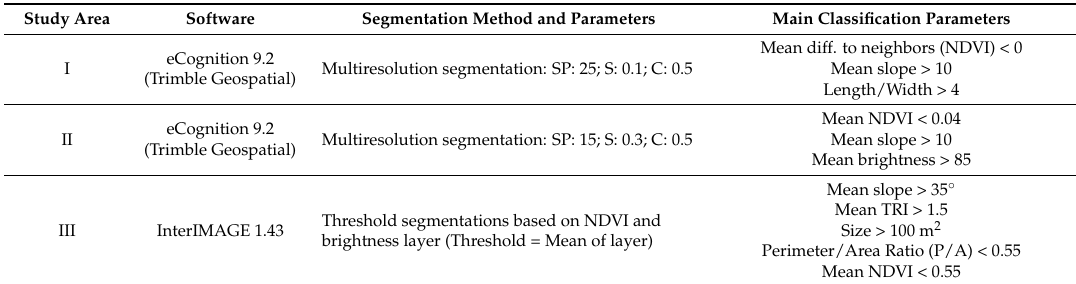
Table 2. Software, the segmentation method and parameters (SP—Scale Parameter, S—Shape criterion, C—Compactness criterion), and the main classification parameters used for object-based landslide mapping for each case